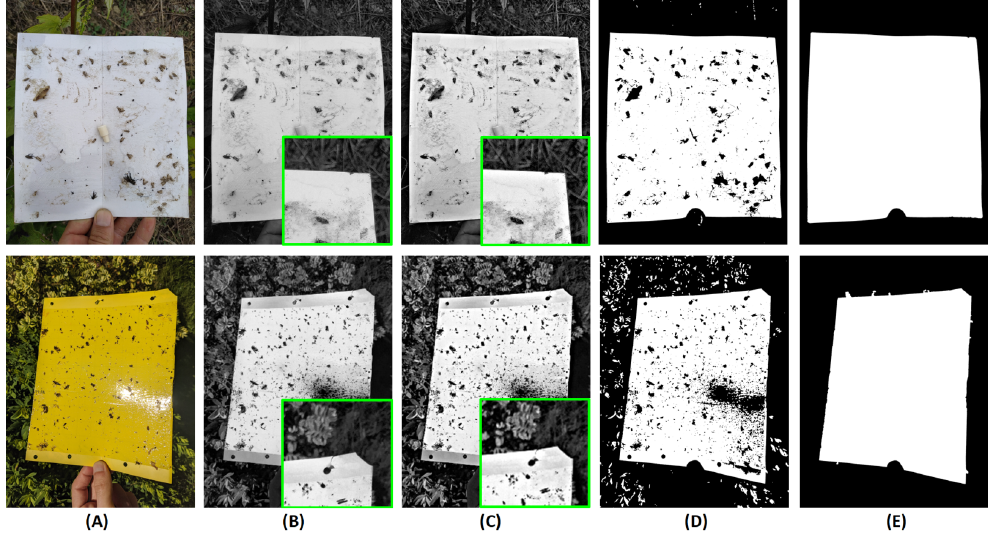
Figure 6. Trap segmentation: ( A ) original RGB image; ( B ) grayscale image; ( C ) sharpening; ( D ) Otsu’s segmentation; ( E ) post-processing (morphological operations, area filtering, and